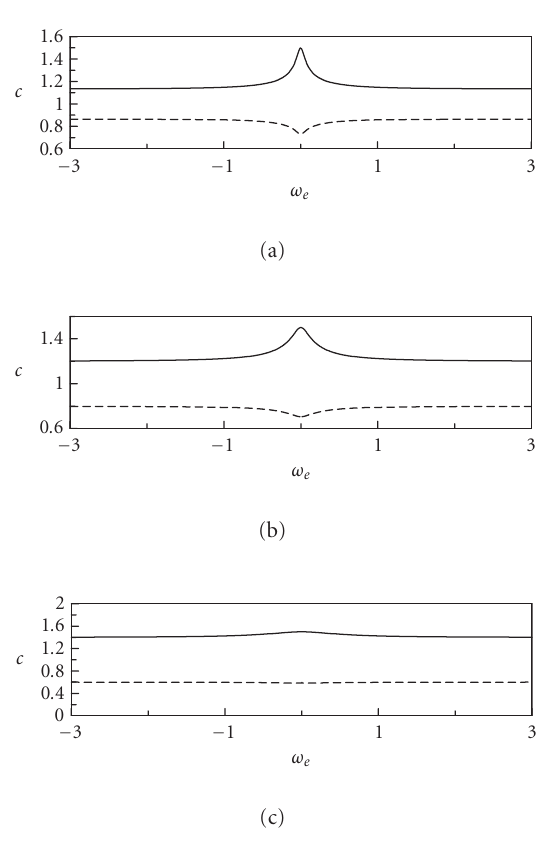
Figure 4.2. Phase speed. The solid line represents growing wave and the dashed line represents the evanescent wave. (a) F = 7 . 5, (b) F = 5, and (c) F = 2 .